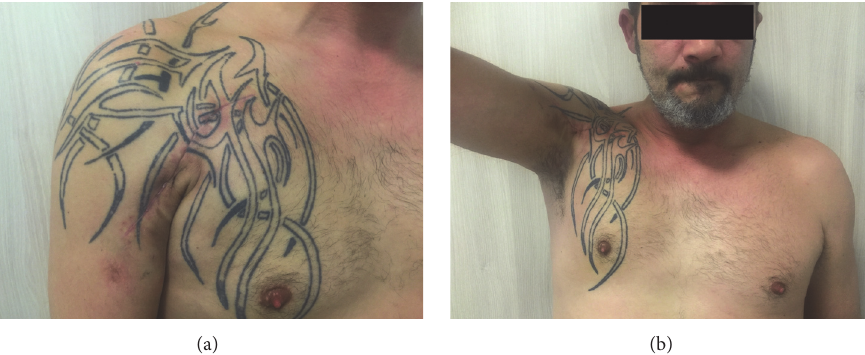
Figure 7: At two months postoperatively, the anterior axillary contour was restored (a), and the range of motion was 110 ∘ in lateral elevation (b).